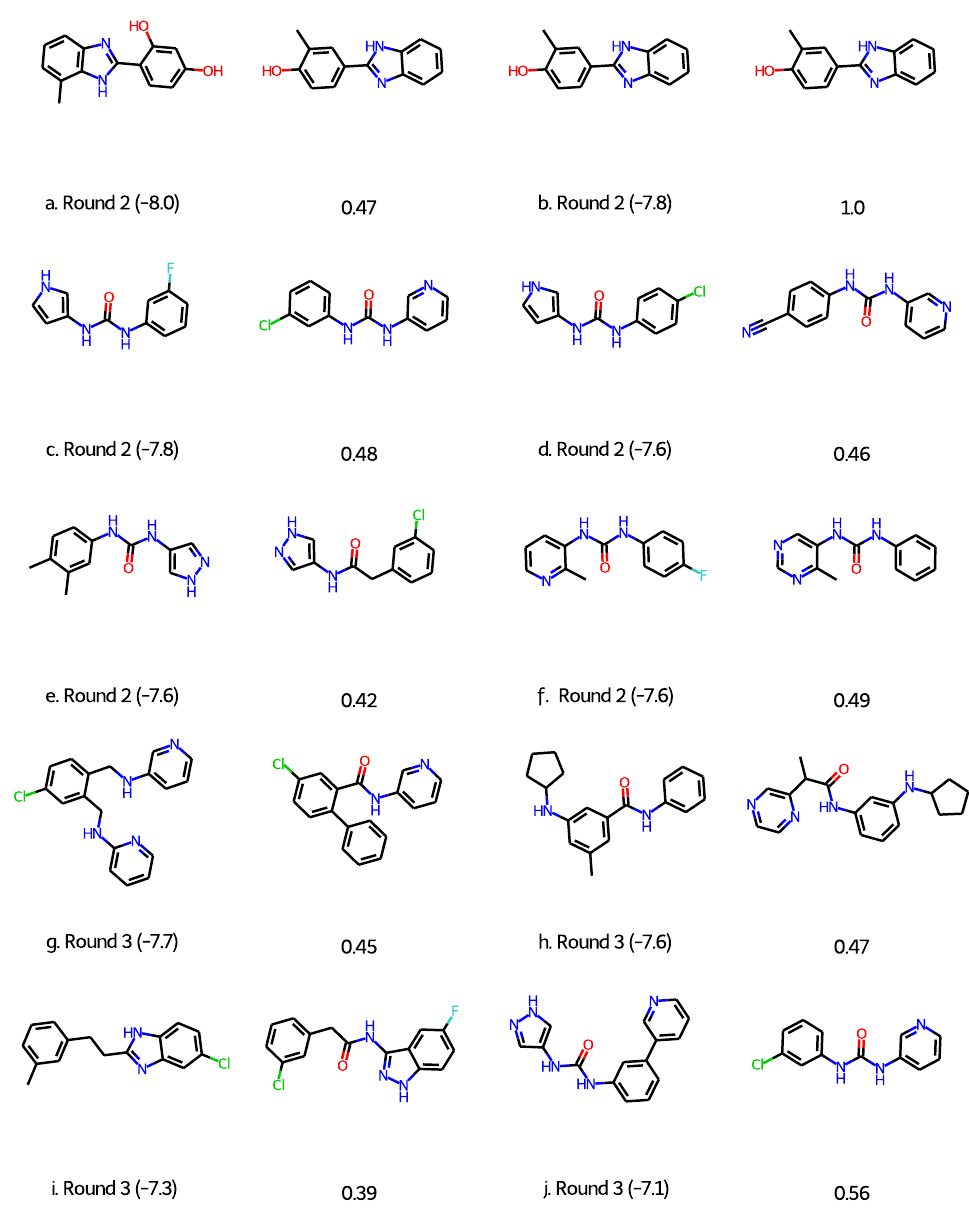
Figure 3 Molecules submitted to the second and third round of the COVID moonshot project (with the corresponding XP docking score in parenthesis). Next to each submitted molecule is a molecule that was selected for further study by the project organizers that most closely matches our submissions (with the corresponding ECFP4 Tanimoto similarity below). All docking scores in